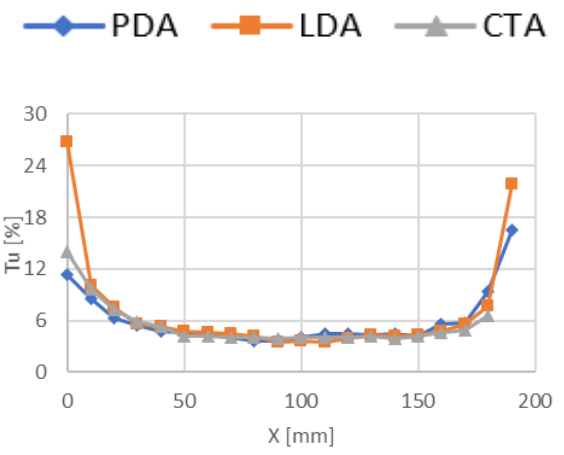
Fig 11. Turbulent intensity, mean velocity of 7 m/s .